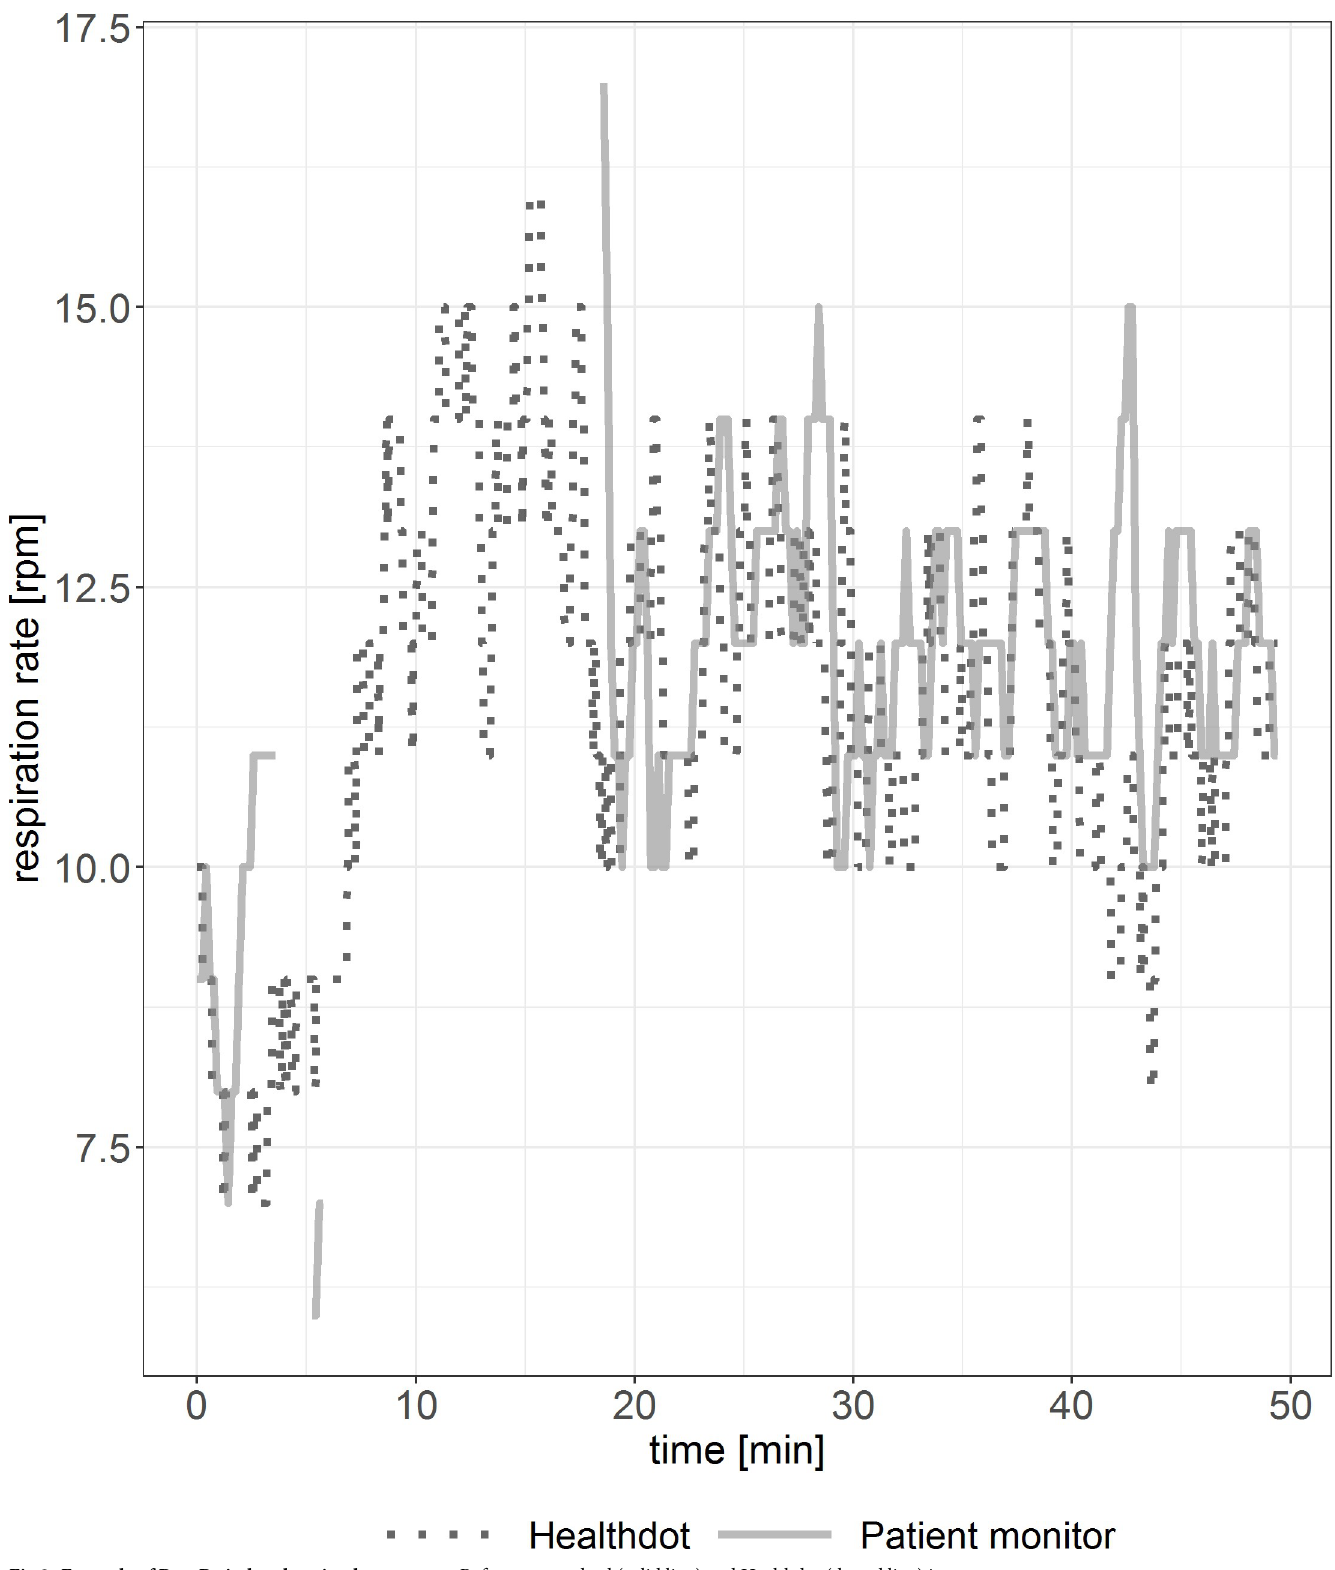
Fig 9. Example of RespR vitals suboptimal agreement. Reference standard (solid line) and Healthdot (dotted line) in rpm.